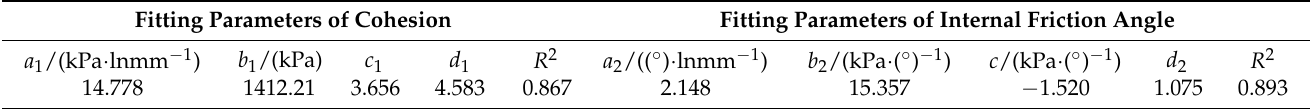
Table 5. Fitting results of the cohesion and internal friction angle of rockfill material soil.